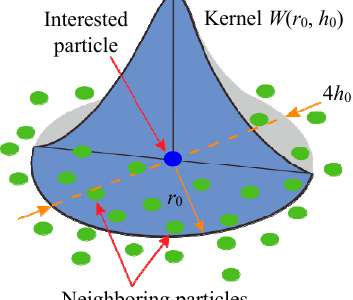
Figure 3. Schematic diagram for the kemel approximation in the smoothed particle hydrodynamics (SPH) method [49].